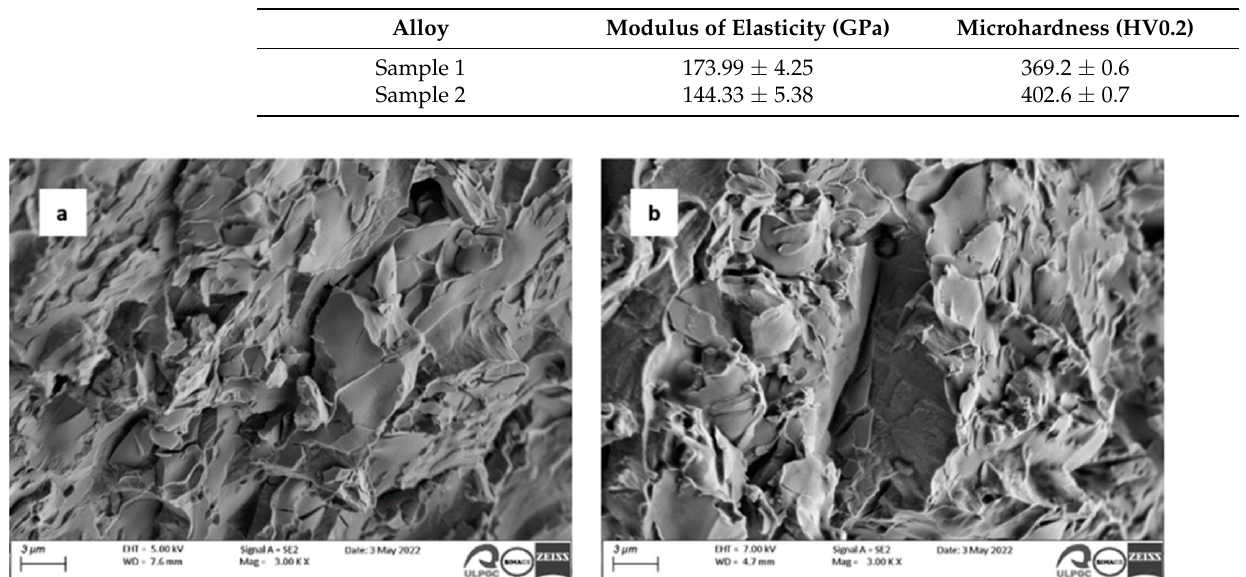
Figure 4 . SEM images of the fracture after three-point bending test: ( a ) Sample 1 and ( b ) Sample 2. The potentiodynamic polarization curves were obtained during the tests carried out to estimate the corrosion rate (CR) of the samples. The current values are presented on a semi-logarithmic scale in Figure